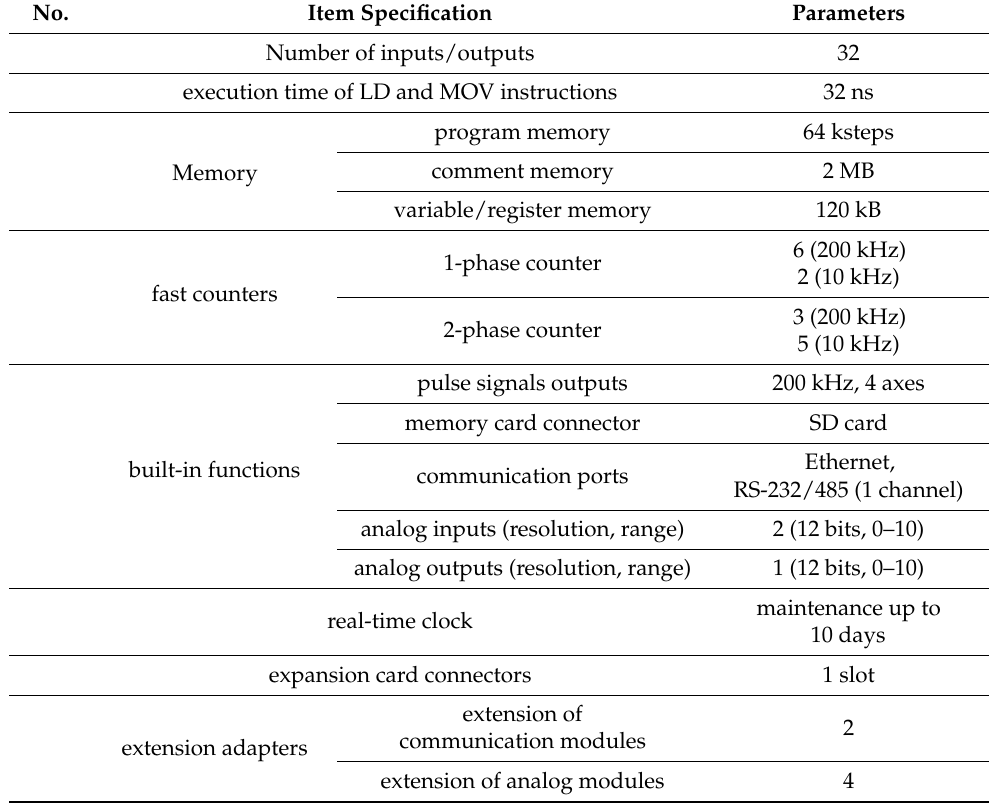
Table 1. Basic parameters of the Mitsubishi Electric FX5-32MT controller.